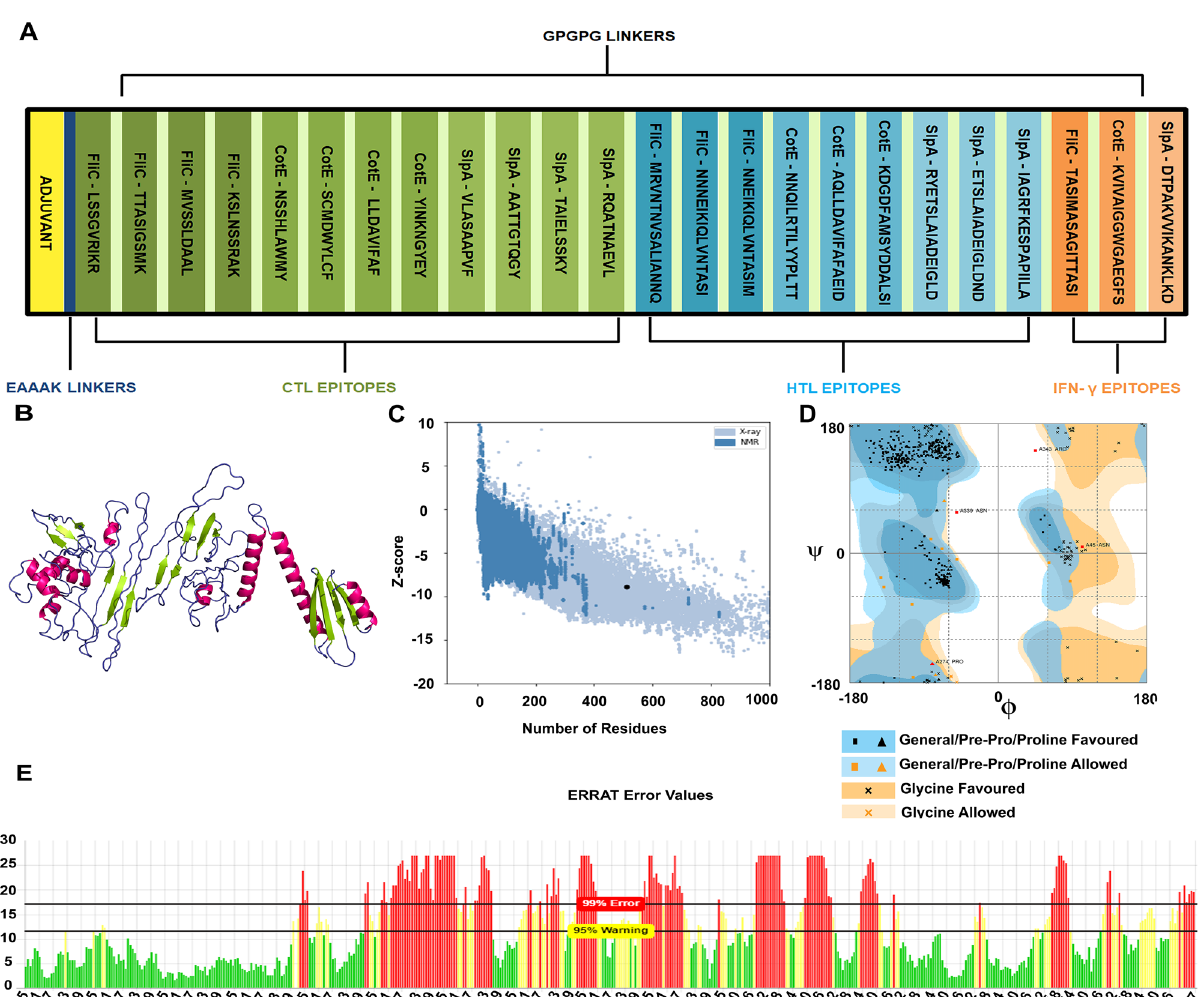
Figure 3. ( A ) Schematic representation of linear vaccine construct showing CTL epitopes in green colour, HTL epitopes in blue colour and IFN-γ in orange colour. Pale green colour represents GPGPG linkers, which have been used to link epitopes together. CTB adjuvant is represented in yellow colour, joined to the linear vaccine using deep blue EAAAK linker. ( B ) Tertiary structure of the vaccine. Limon, blue and hot pink colour represents the sheets, loops and helices, respectively. ( C ) Protein structure validation by ProSA with a Z-score of − 8.92. ( D ) Ramachandran plot analyses showing 96.5%, 2.7% and 0.8% in favoured, allowed and outlier regions, respectively as predicted by RAMPAGE ( E ) Protein structure validation by ERRAT score of 53.3865, where X axis denotes residues and Y axis denotes error between the CTL epitopes with MHC I and HTL epitopes with MHC II have been shown in Supplementary Figs. S5 and S6. Docking of the vaccine with TLR4. The HADDOCK server necessitates the ambiguous interaction restrains (AIRs), which highlights the active and passive residues of the receptor and the ligand required for docking. The interaction in between molecules and available solvent involves the active residues, while the surface neighbour active residues denote the passive residues. Here, the vaccine candidate is docked with the TLR4 heterodimer to study the interaction between vaccine and TLR4. Among the many predicted clusters, the best reliable cluster with the lowest HADDOCK score was subjected to refinement by the HADDOCK Refinement Server. The sta- tistics of the refined structure is detailed in Table 6 and Supplementary Fig. S7. During refinement, 20 structures were clustered into one cluster, resulting in 100% water refined model. After refinement, the model showed a HADDOCK score of − 204.2 ± 2.0 a.u., which suggests good binding affinity between the receptor (TLR4) and ligand (vaccine) as a negative HADDOCK score suggests better docking. Less water-exposed protein surface and close binding proximity is indicated by the Buried Surface Area (BSA) of 5042.9 ± 160.6 Å 271 . A low RMSD score of 0.3 ± 0.2 Å of the docked structure indicates a good quality model. A detailed overview of the docked complex along with interacting amino acid residues are shown in Supplementary Fig. S8. The docked complex along with the interacting residues is shown in Fig. 5 and detailed interaction is given in Supplementary Material SM3.